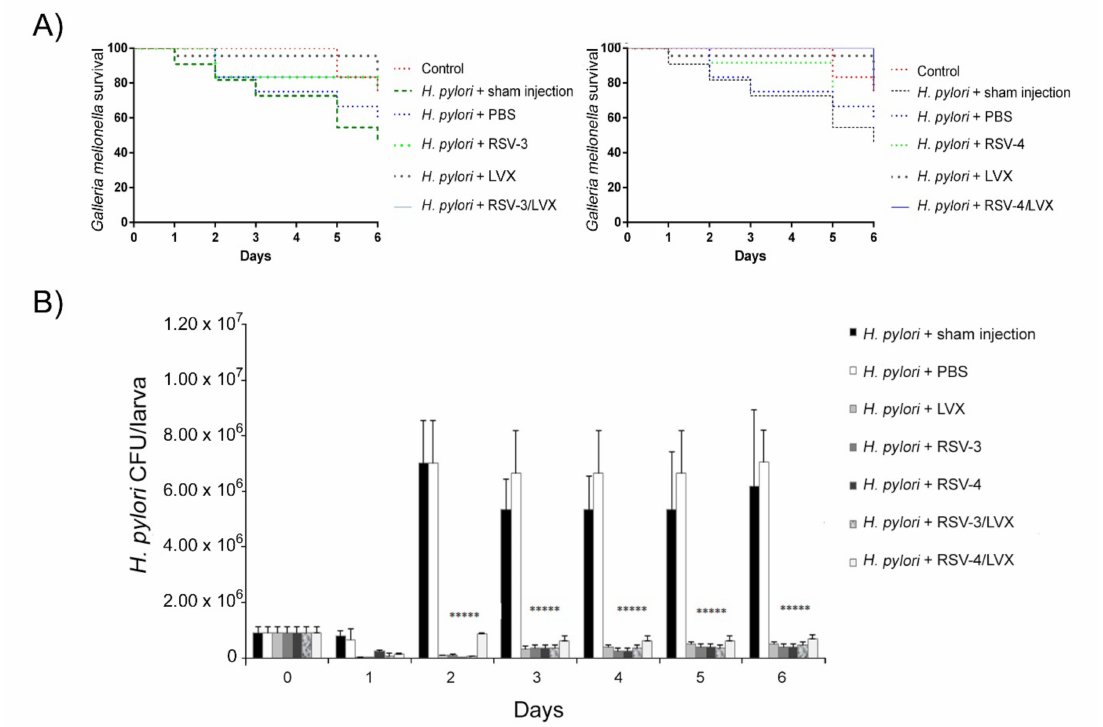
Figure 6. In Vivo infection assay in Galleria mellonella larvae. ( A ) Kaplan Meyer survival curves of G. mellonella infected with H. pylori 13A / 13 strain for 2 h, then treated with PBS, LVX, RSV-3, RSV-4, and LVX + RSV-3, LVX + RSV-4 at the best synergistic combination. ( B ) Recovery of H. pylori 13A / 13 CFU / larva in G. mellonella at di ff erent time points and di ff erent conditions (sham injection, PBS, LVX, RSV-3, and RSV-4 and the best synergistic combination of RSV-3 / LVX, RSV-4 / LVX). ***** Statistically significant values with respect to the